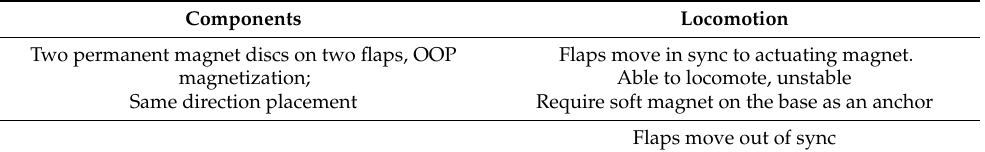
Table 2. Combinations of magnets and magnetization direction and observations from their loco- motion .